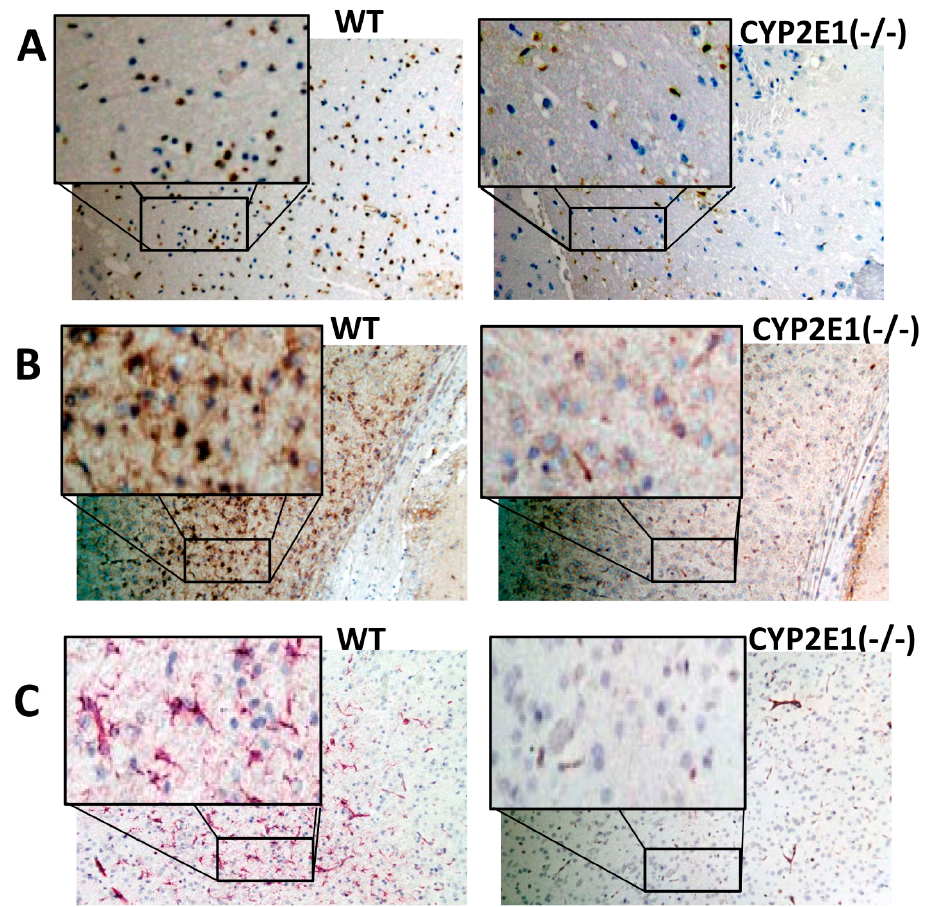
Figure 3. Apoptosis and neurodegeneration were reduced in CYP2E1( − / − ) mice following I/R (tMCAo). ( A ) apoptosis of mice MCAo brain tissue in each group measured by terminal deoxynucleotidyl transferase-mediated dUTP-biotin nick end labeling (TUNEL) (magnification, ×200) in the MCA territory of the cortex. TUNEL-positive cells (brown staining) significantly decreased in CYP2E1 compared with those in the WT group. TUNEL assay was performed in the cortical cerebral sections. TUNEL-positive cells were counted. Representative figures show CYP2E1 inhibition reduces expression of ( B ) microglia/macrophage activation (ionized calcium-binding adaptor protein-1 (Iba-1) positive cells), and ( C ) astrogliosis following tMCAo and 24 h reperfusion (astrocytes glial fibrillary acidic protein (GFAP) positive cells) in the peri-infarct cortex. Astrocytes stained brown.